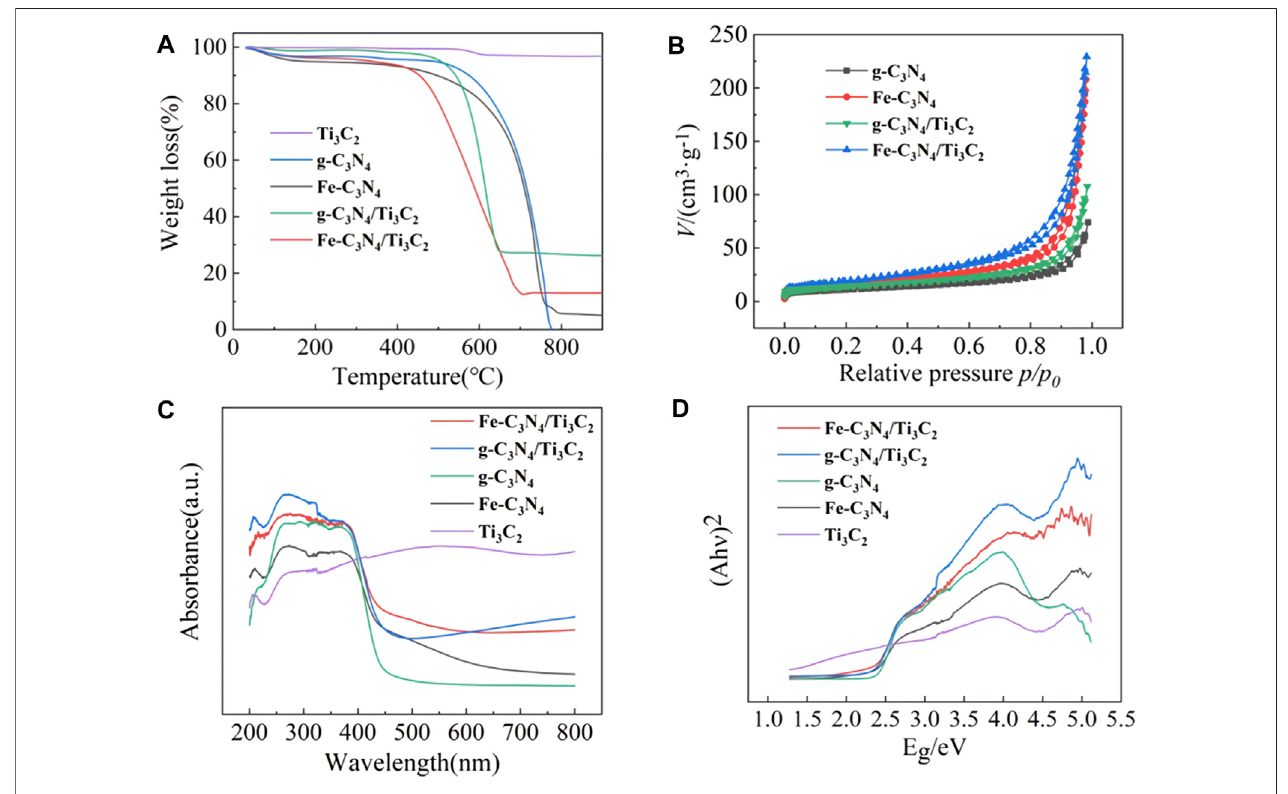
FIGURE 5 | (A) The TGA curves of Ti 3 C 2 , g-C 3 N 4 , Fe-C 3 N 4 , g-C 3 N 4 /Ti 3 C 2, and Fe-C 3 N 4 /Ti 3 C 2. (B) N 2 adsorption-desorption isotherms of different materials. (C) UV-Vis diffuse re fl ectance spectra and (D) band gap of g-C 3 N 4 , Ti 3 C 2 , Fe-C 3 N 4 , g-C 3 N 4 /Ti 3 C 2 and Fe-C 3 N 4 /Ti 3 C 2